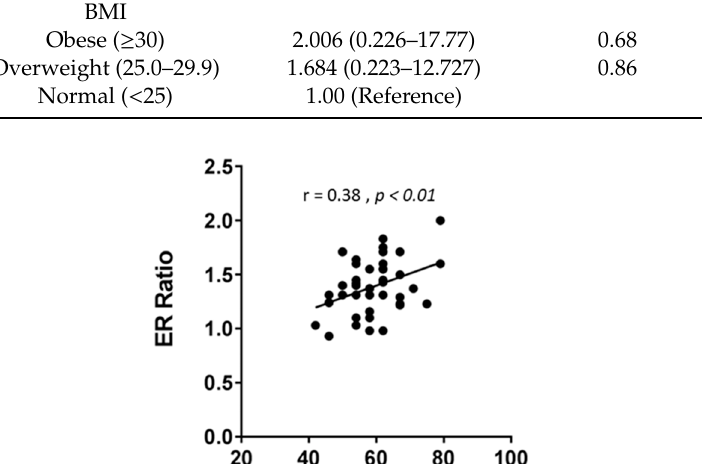
Figure 5. Scatter plot showing correlation between job stress indicators, effort–reward ratio, and overcommitment. Job stress (ER ratio, and OC) was determined from the effort–reward imbalance (ERI) questionnaires filled out by study participants ( n = 42). ERR and OC scores were found to be normally distributed. Pearson r correlation was used to define relationship between ERR and OC scores (Pearson r correlation = 0.38, 95% CI 0.087–0.614, p = 0.01).